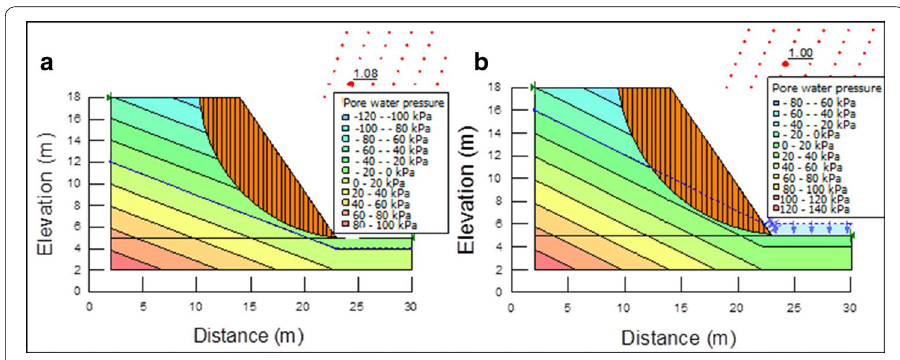
Fig. 12 Slope pore pressure model. a Dry season, b rainy